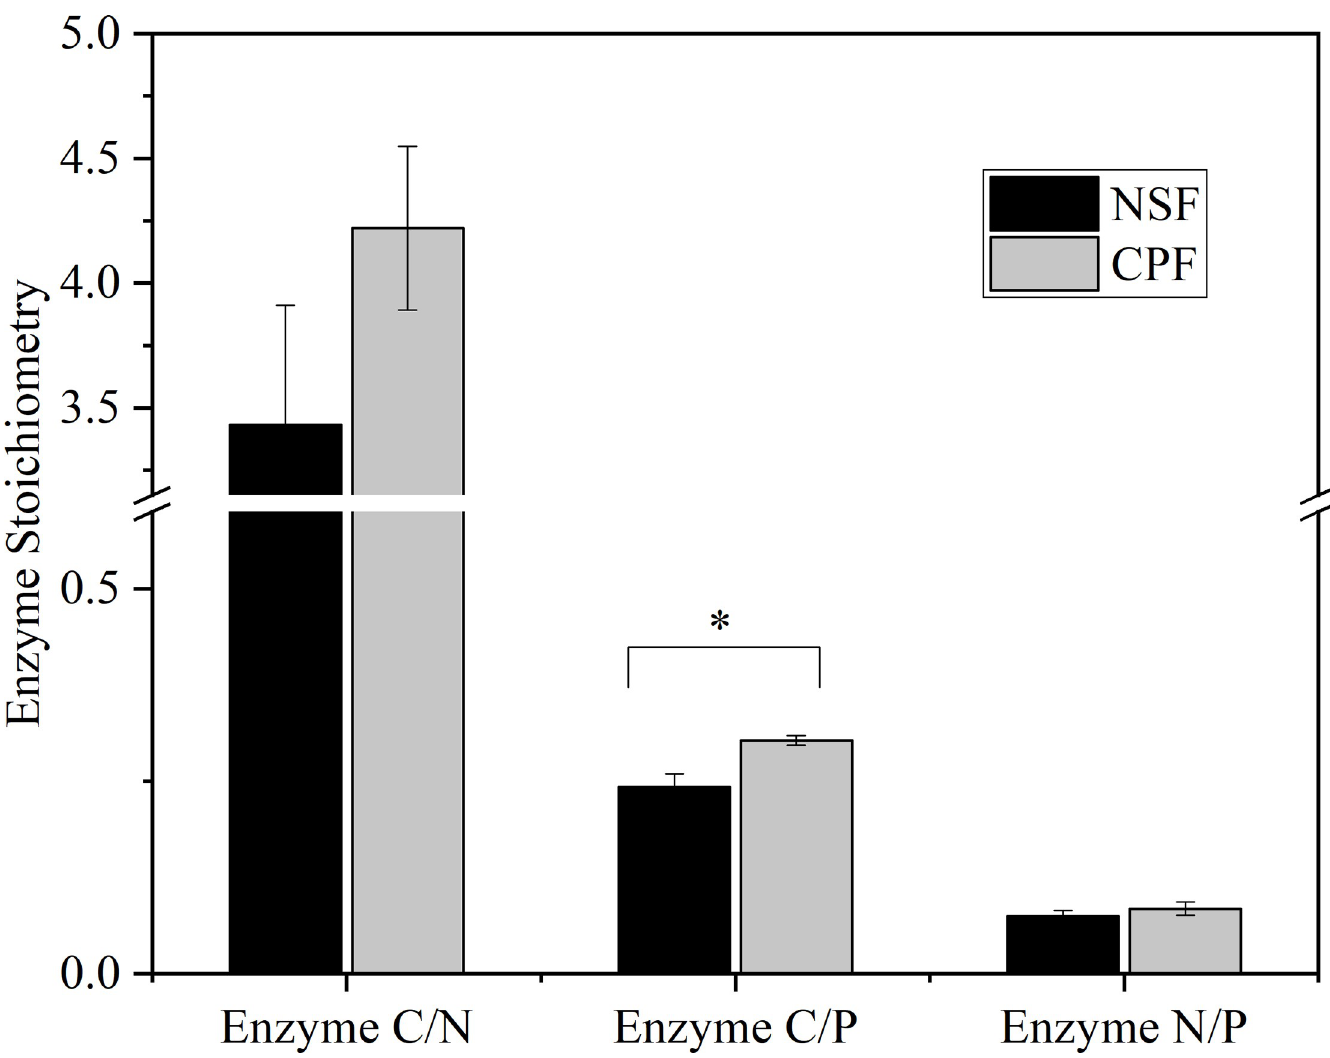
Fig 3. Comparisons of enzymatic stoichiometry at the 0–60 cm soil depth of the natural secondary forest (NSF) and Chinese fir plantation forest (CPF). All values are presented as mean ± standard error. “ � ” indicates a significance at a p < 0.05 level.